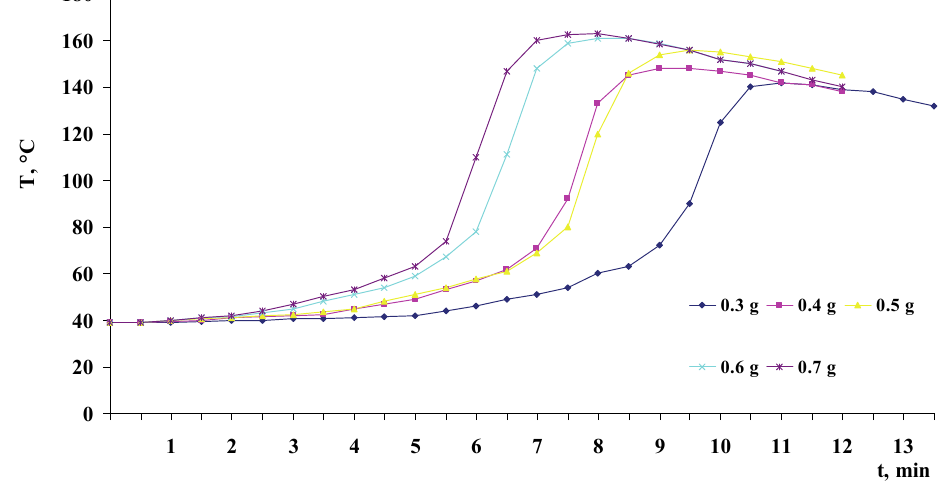
Figure 2: Dependence on the reaction temperature with the time for the copolymerization of unsaturated polyester resin with different amount of